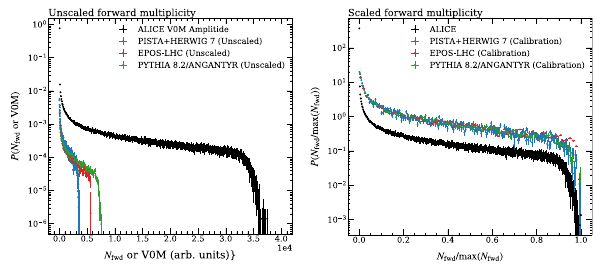
Fig. 4 Comparisonofgeneratedcentralitymeasuregeneratedby Her- wig + Pista , Epos- lhc and Pythia 8.2/ Angantyr to V0M Amplitude from ALICE. To the left a direct comparison, and to the right a rescaled one (see